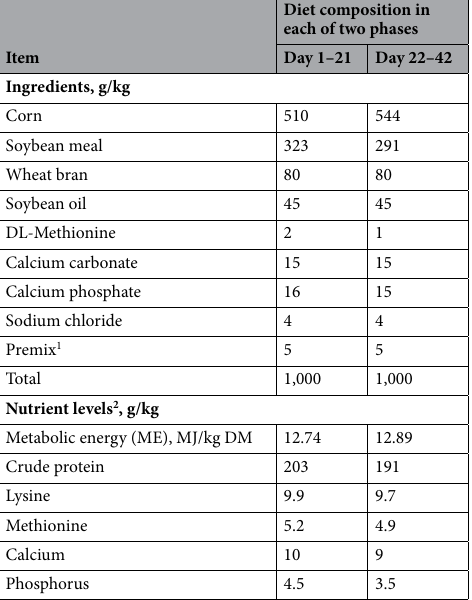
Table 3. Compositions and nutrient levels of the basal diets. 1 Supplied per kilogram of complete